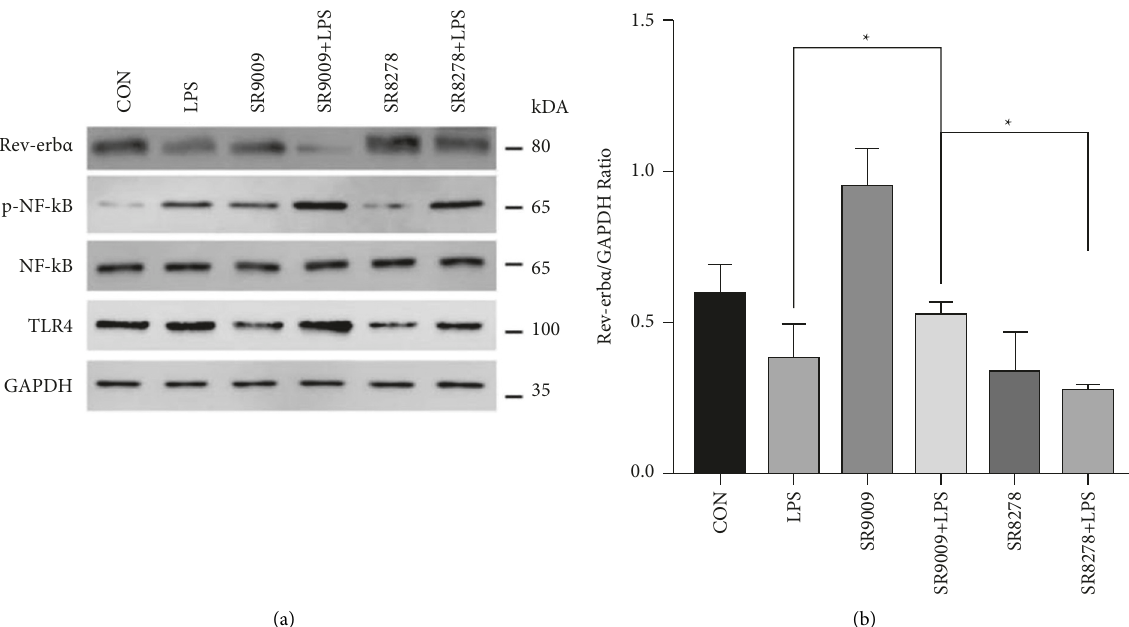
Figure 4: (a) Western blot analysis of Rev-Erb α , NF- κ B, and TLR4 expression in RAW246.7 treated with DMSO, LPS, SR9009, SR9009+LPS, SR8278, and SR8278+LPS and (b) Rev-Erb α /GAPDH ratio in RAW246.7 after LPS induction and SR9009 and SR8278 treatment. Significant difference: ∗ p < 0 .